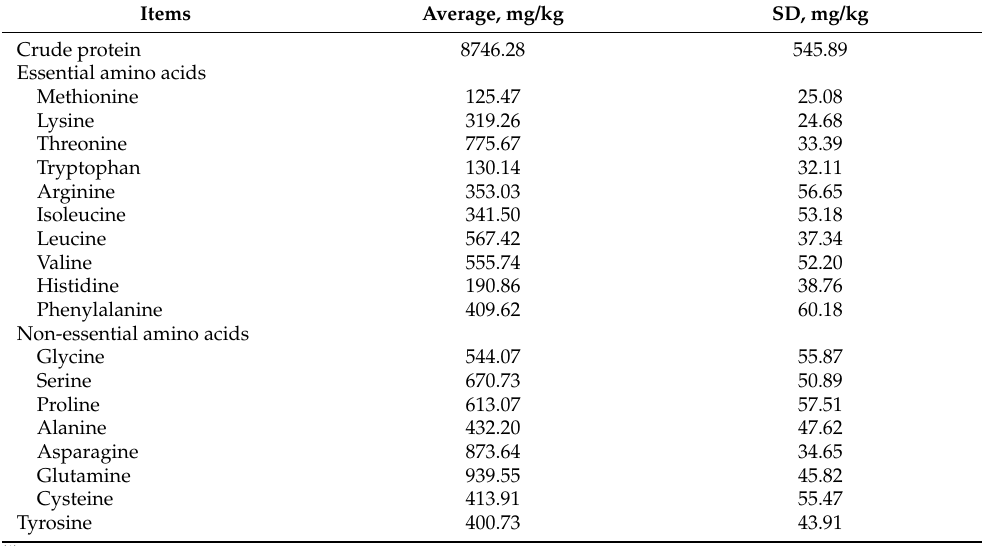
Table 6. The AID and SID values of essential amino acids (methionine, lysine, leucine and phenylalanine) were higher for FPNM than for PNM ( p < 0.05). Moreover, the AID and SID values of non-essential amino acids of FPNM were both higher than those of PNM, except for proline ( p < 0.05). Table 5. Concentration of the ileal endogenous amino acid losses of the broilers fed a nitrogen-free diet (dry matter basis, n = 6) (1)